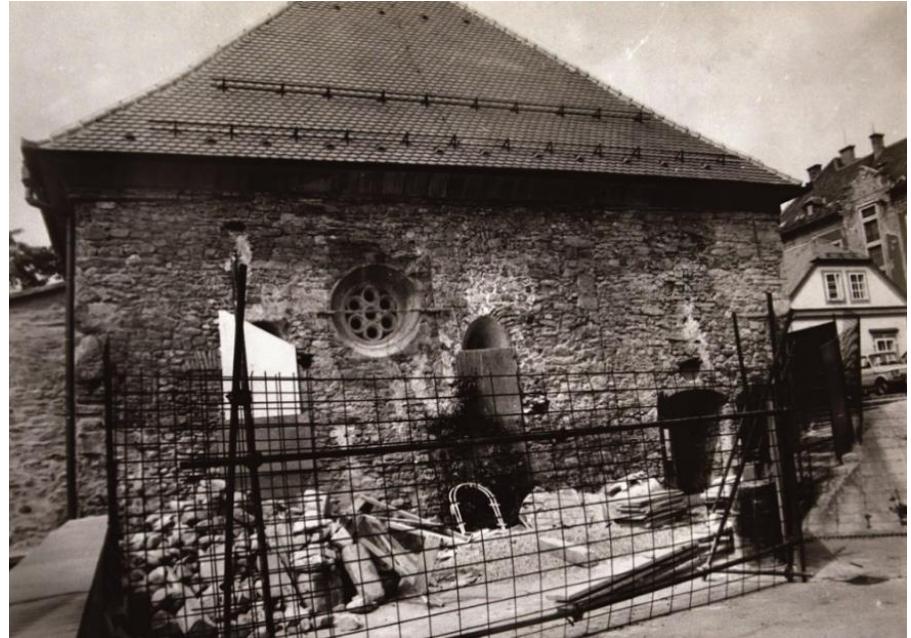
Figure 5. Eastern façade after removal of the annexed building. The openings in the wall with the rosette window and portal, leading to the lower floor of the northern annex, are clearly visible. Photo: The Maribor Regional Office of the Institute for Protection of the Cultural Heritage in Slovenia (IPCHS), Fond Maribor—Sinagoga.